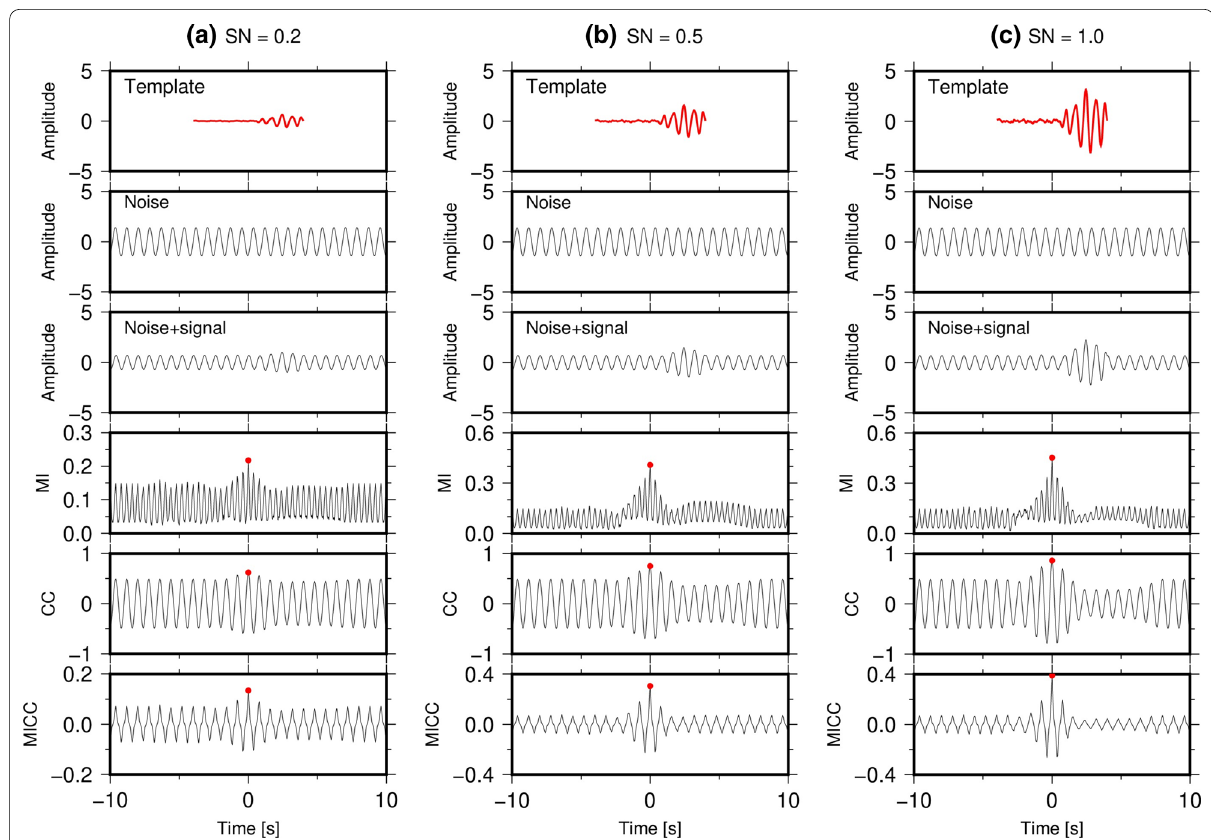
Fig. 5 1.25-Hz sine wave used as noise combined with template waveforms at SN ratios of ( a ) 1.0, ( b ) 2.0, and ( c ) 3.0. The values of MI, CC, and MICC are calculated at each time. Red dots show the index corresponding to the template